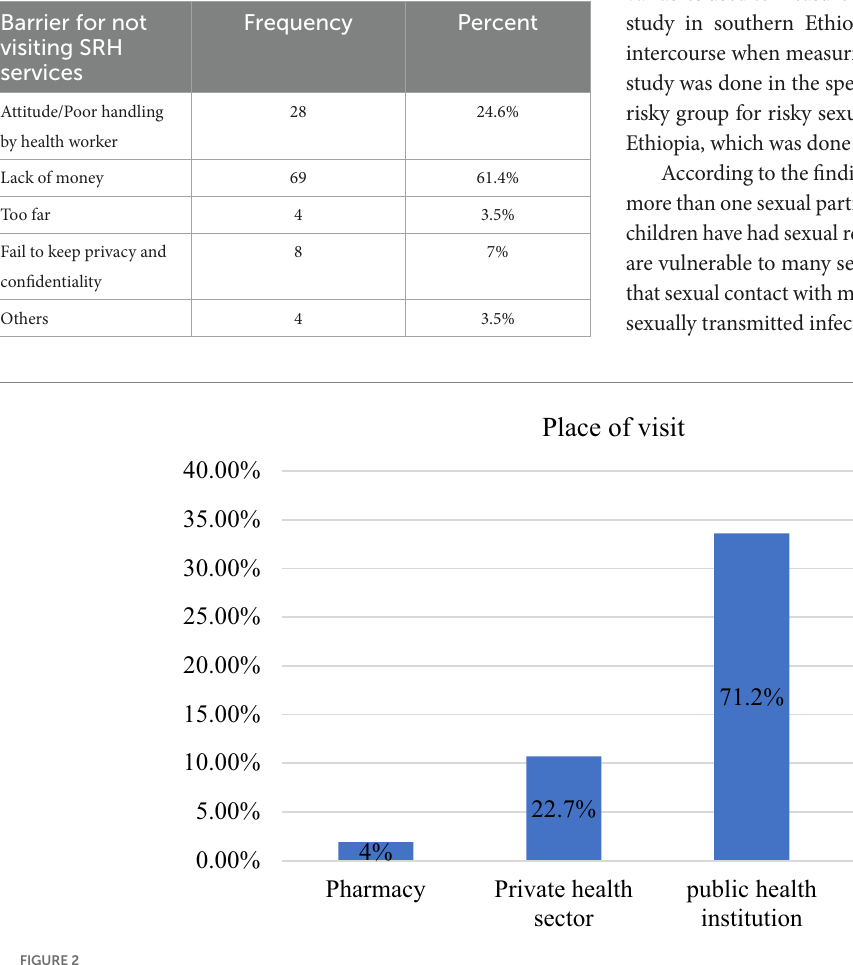
FIGURE 2 Type of health institution frequently visited by street children for SRH services in Wonago town, September 2021 ( N =